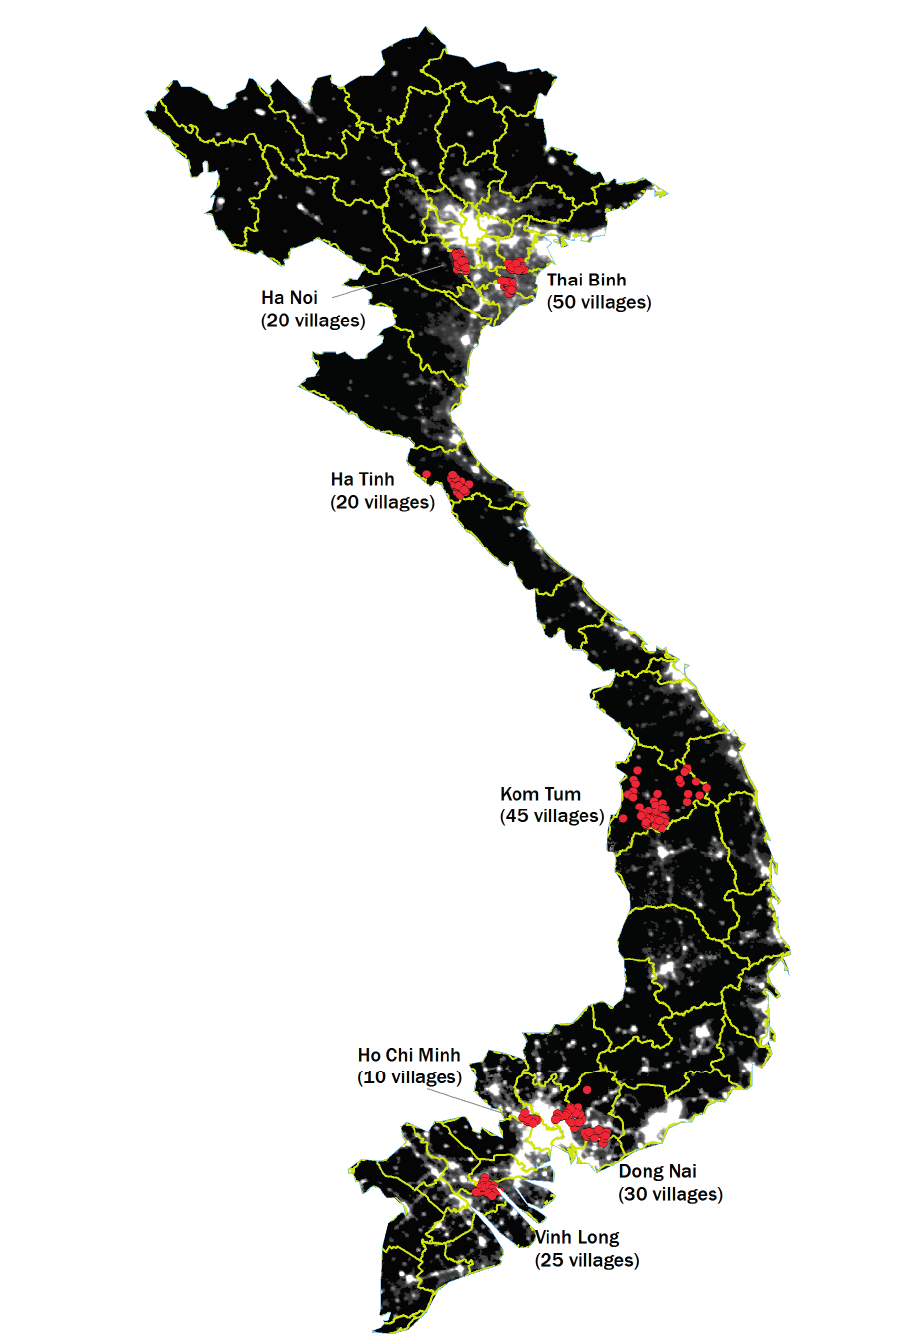
Figure 3. Location of surveyed